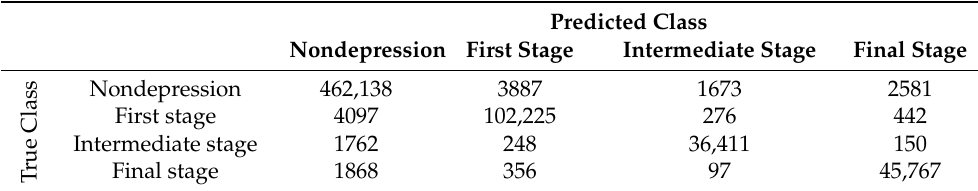
Table 7. Confusion matrix obtained by the four-class classification in Setting 1.